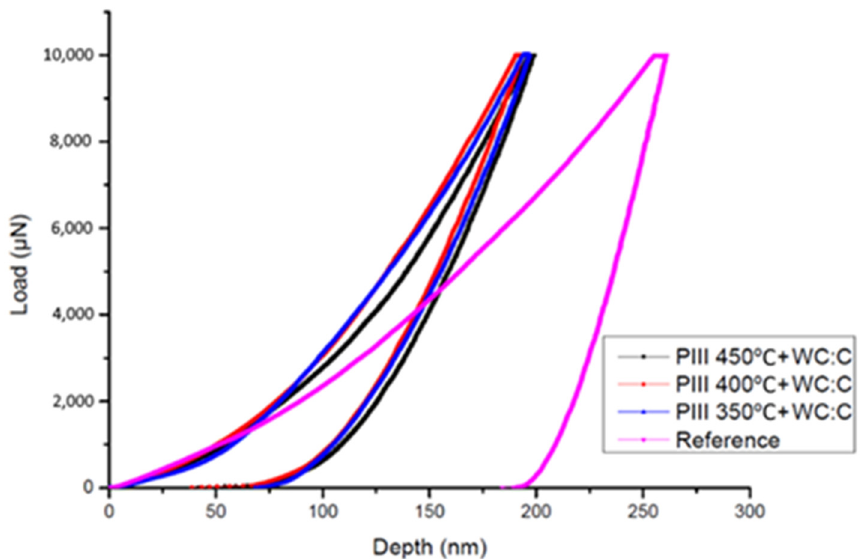
Figure 14. Nanoindentation curves for the PIII 450 °C + WC:C coating (black line), PIII 400 °C + WC:C coating (red line), PIII 350 °C + WC:C coating (blue line) and reference AISI 316-L (purple WC:C coating (red line), PIII 350 ◦ C + WC:C coating (blue line) and reference AISI 316-L (purple line).